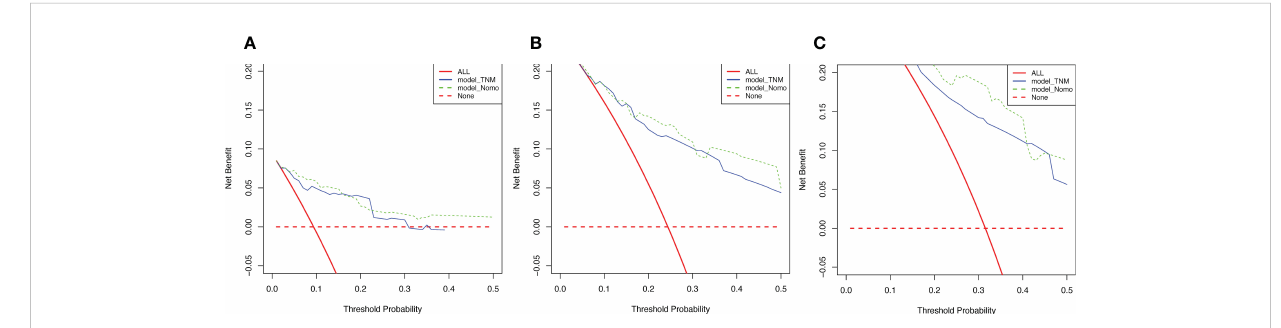
FIGURE 7 Decision curves of two models. (A) Decision curves of 1-year OS. (B) Decision curves of 3-year OS. (C) Decision curves of 5-year